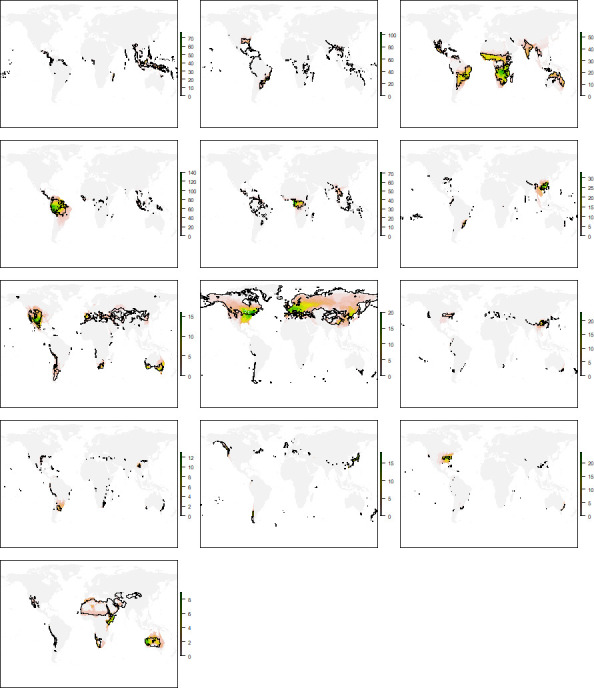
Distribution of the climatic conditions (black line) and the species (colored richness values) belonging to the same niche domains of amphibians.